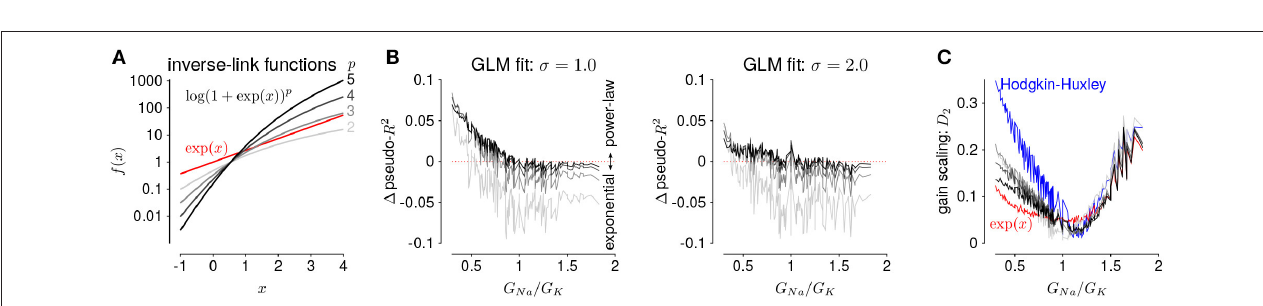
FIGURE 7 | (A) The five inverse-link functions tested in the GLM. The red trace shows the canonical exponential inverse-link function used in Figures 4 , 5 . The gray traces show the soft-power function for different exponents, p . (B) The difference in predictive performance (measured as pseudo- R 2 ) between the exponential GLMs and the power-law GLMs for p ∈ { 2,3,4,5 } for a test stimulus of σ = 1.0 (left) and σ = 2.0 (right). Positive values indicate the GLM with a power-law non-linearity had greater predictive performance than the exponential GLM. The GLMs were fit to all σ . (C) Gain scaling predicted by the power-law GLMs (gray traces) compared to the exponential GLMs (red) and the HH simulations